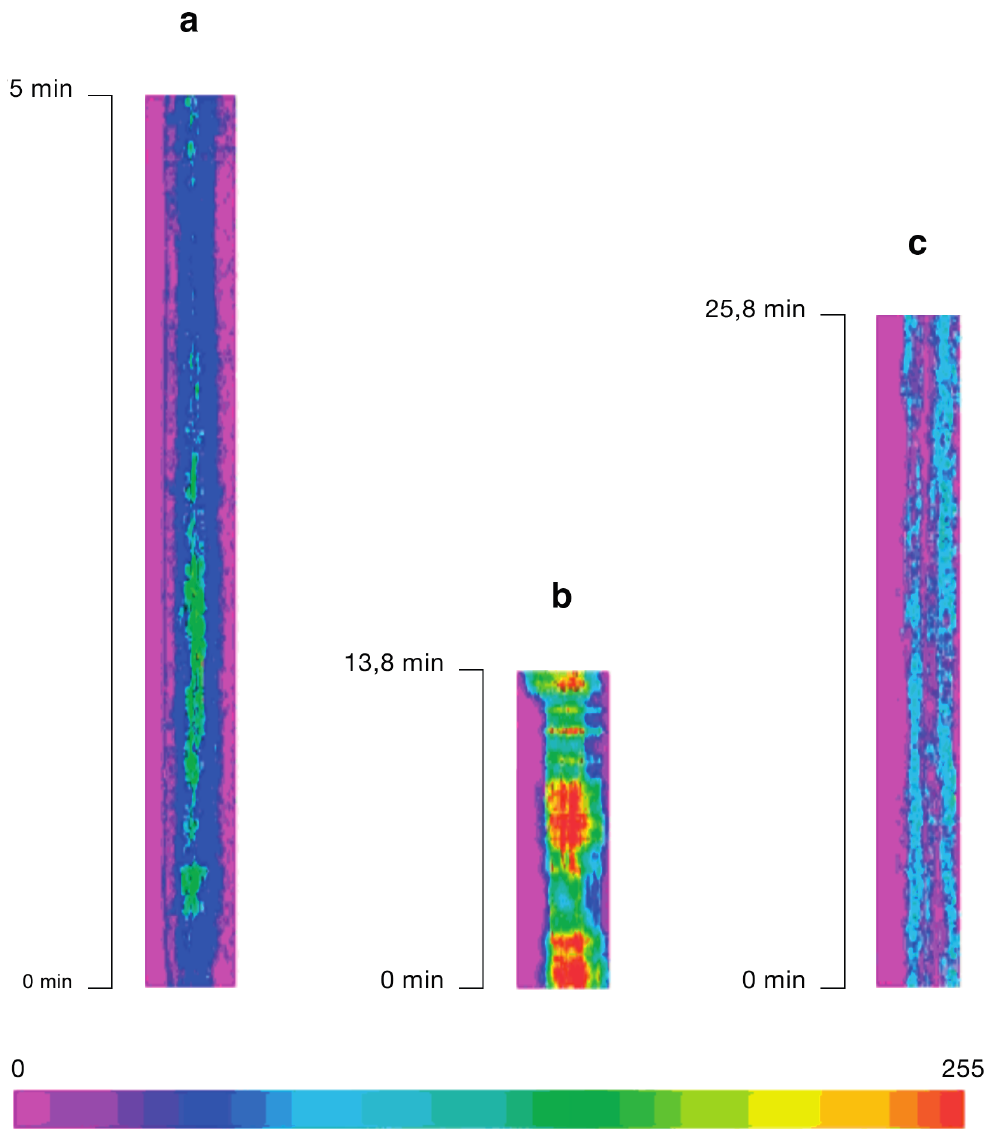
Figure 1. Calcium dynamics in reconstructions of temporal sections obtained with the Line Image function of the Lucida software. The line trace plot is represented as pixel intensities converted into pseudocolor values in the Line Image. Rows in the Line Image correspond to successive images ( x ) along the active dimension, time ( t ). Thus, the Line Image is an ( x , t ) plot showing [Ca 2+ ] cyt change along an axis through the “stack” image composed of the overlaid images taken successively during [Ca 2+ ] cyt measurement. The increase in [Ca 2+ ] cyt is represented by yellow-red bands. The bar represents a pseudocolor code of the pixel values digitized to 256 grey levels. ( a ) Line Image of an egg cell isolated three DAE, injected with fura-2 dextran and ratio-imaged following electrofusion with a sperm cell. The axis along which the [Ca 2+ ] cyt changes were measured passed through the sperm entry site; ( b ) [Ca 2+ ] cyt changes over time in a receptive egg cell (isolated six DAE) microinjected with fura-2 dextran and fertilized in vitro ; ( c ) Time-lapse series of an axis “drawn” through time, the active dimension, in an overmature (18 DAE) egg cell fertilized in vitro following fura-2 dextran